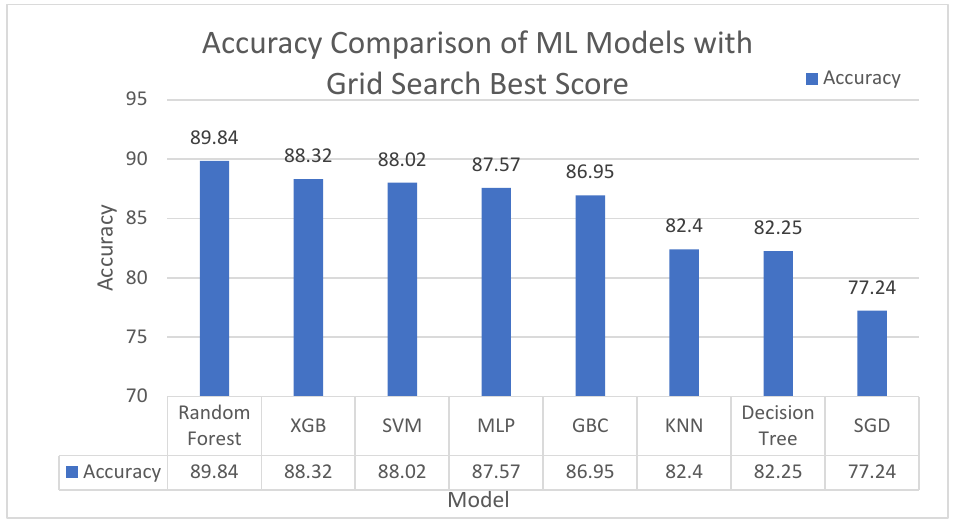
Figure 7. Accuracy Visualization of ML Classifier w.r.t 10-Cross Validation.